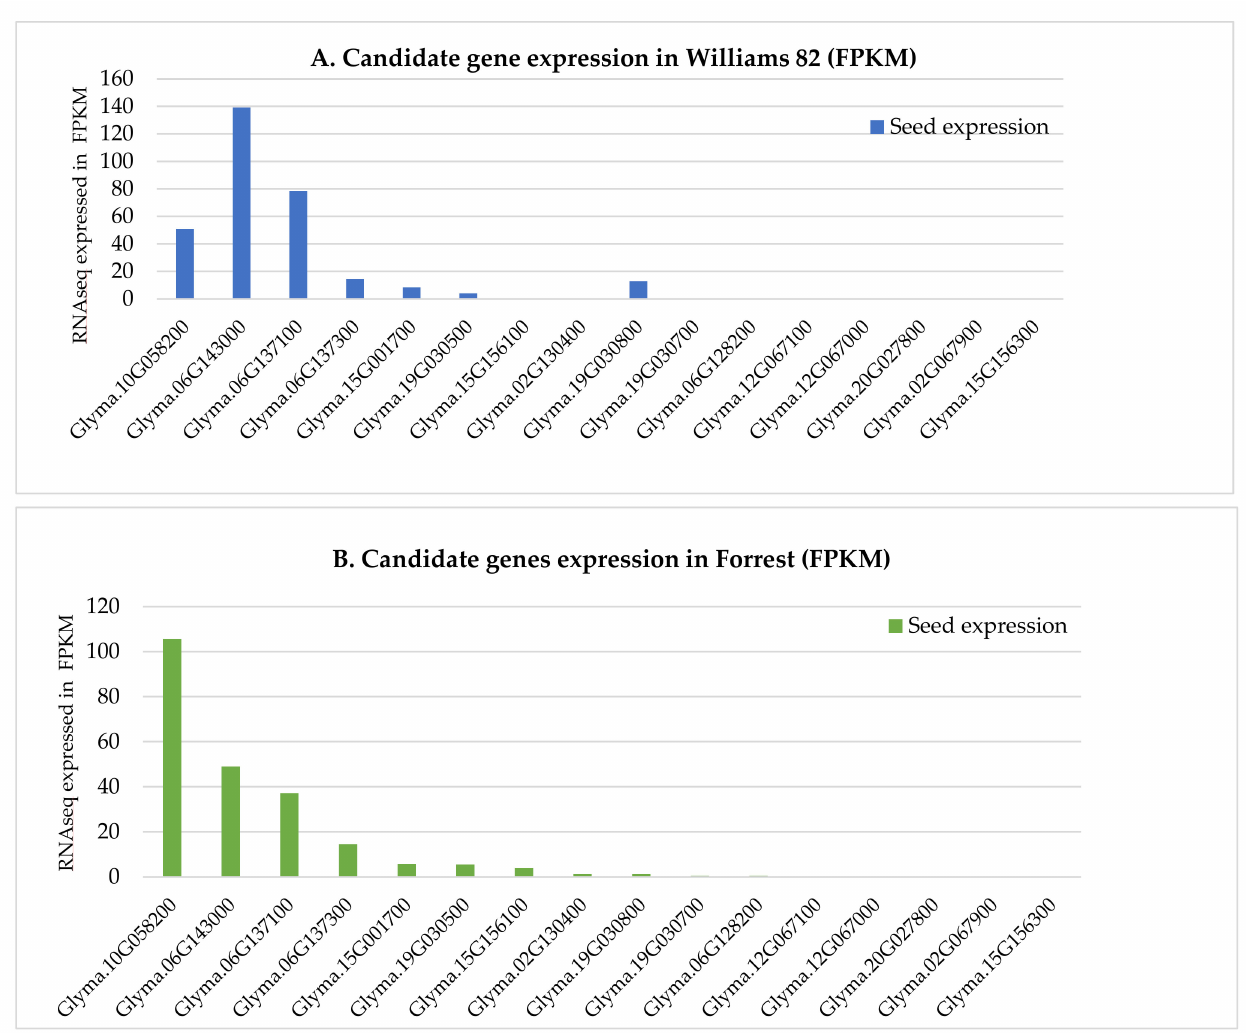
Figure 5. Expression pattern of isoflavone genes in soybean seeds. ( A ) Expression of the 16 isoflavone genes located within isoflavone QTL in Williams 82 (FPKM) were retrieved from publicly available RNA-seq data from Phytozome database [45], in addition to ( B ) the RNAseq data from the cultivar ‘Forrest’